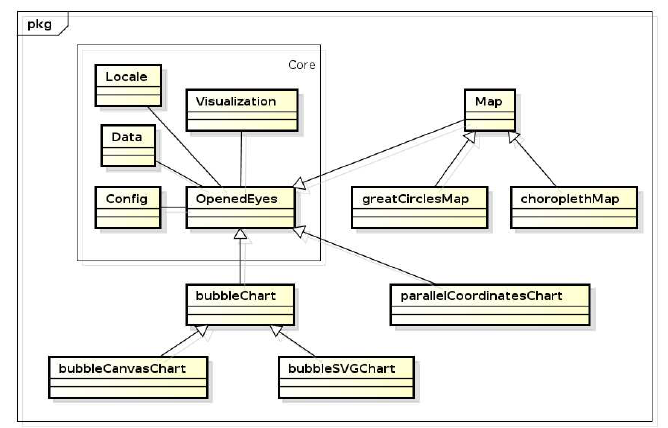
Fig. 3. Simplified OPENEDEYES class